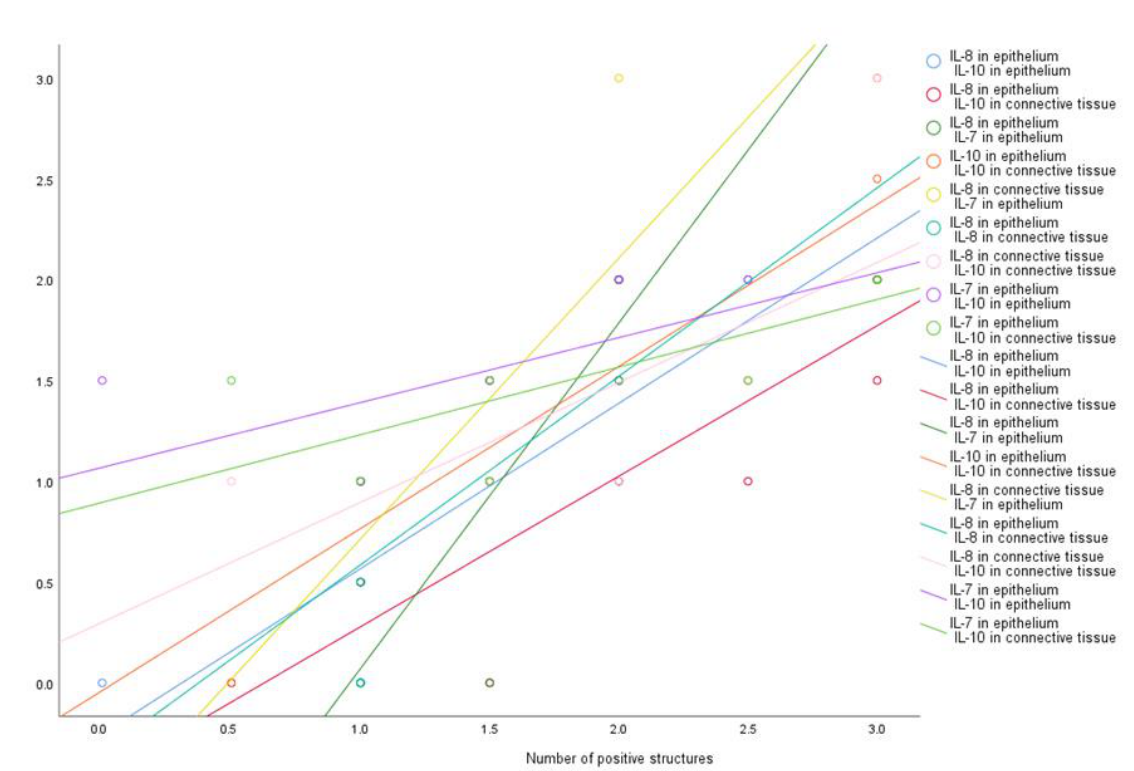
Figure 6. Very strong correlations among cytokines. Abbreviations: IL- 1α — interleukin 1 alpha; IL-4 — interleukin 4; IL- 6 — interleukin 6; IL-7 — interleukin 7; IL-8 — interleukin 8; IL-10 — interleukin 10; IL-12 — interleukin 12.